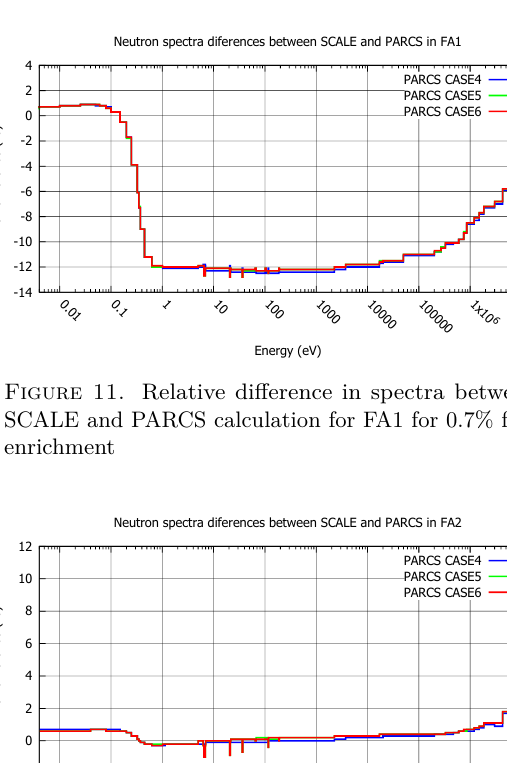
Table 4. k eff relative difference between SCALE and PARCS with multigroup approach for 0.7 % enriched fuel assembly with mirror boundary condition